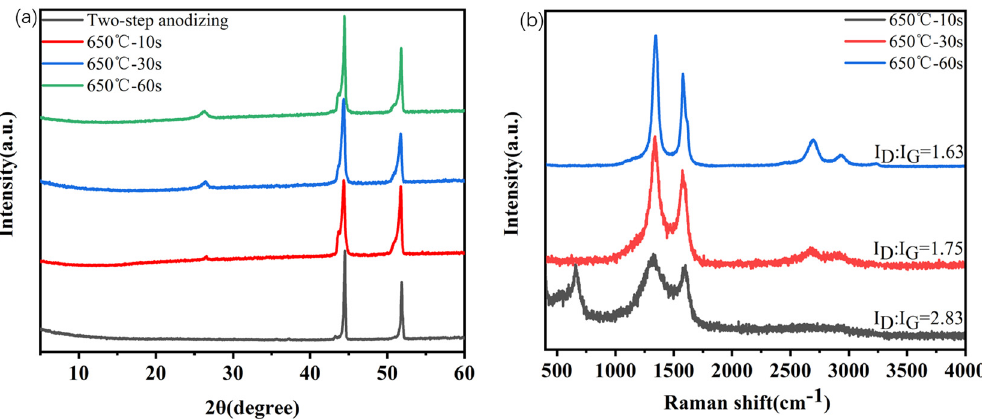
Figure 4: ( a ) XRD spectra of metal surface after CNTs were grown in situ at di ff erent time. ( b ) Raman spectra of metal surface after CNTs were grown in situ at di ff erent time.